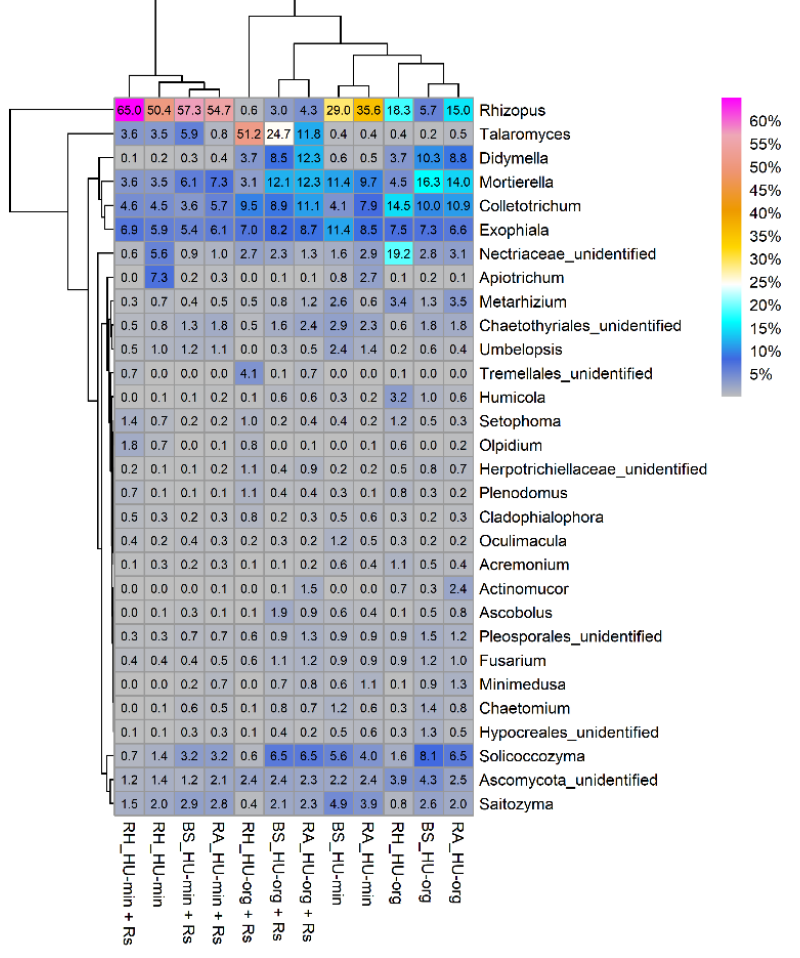
Figure 6. Relative abundance of the 30 most prevalent fungal genera in bulk soil (BS), root-associated soil (RA) and rhizosphere (RH) of lettuce (cv. Tizian) grown in soils with organic (HU-org) or mineral (HU-min) fertilization in the absence and the presence of Rhizoctonia solani AG1-IB